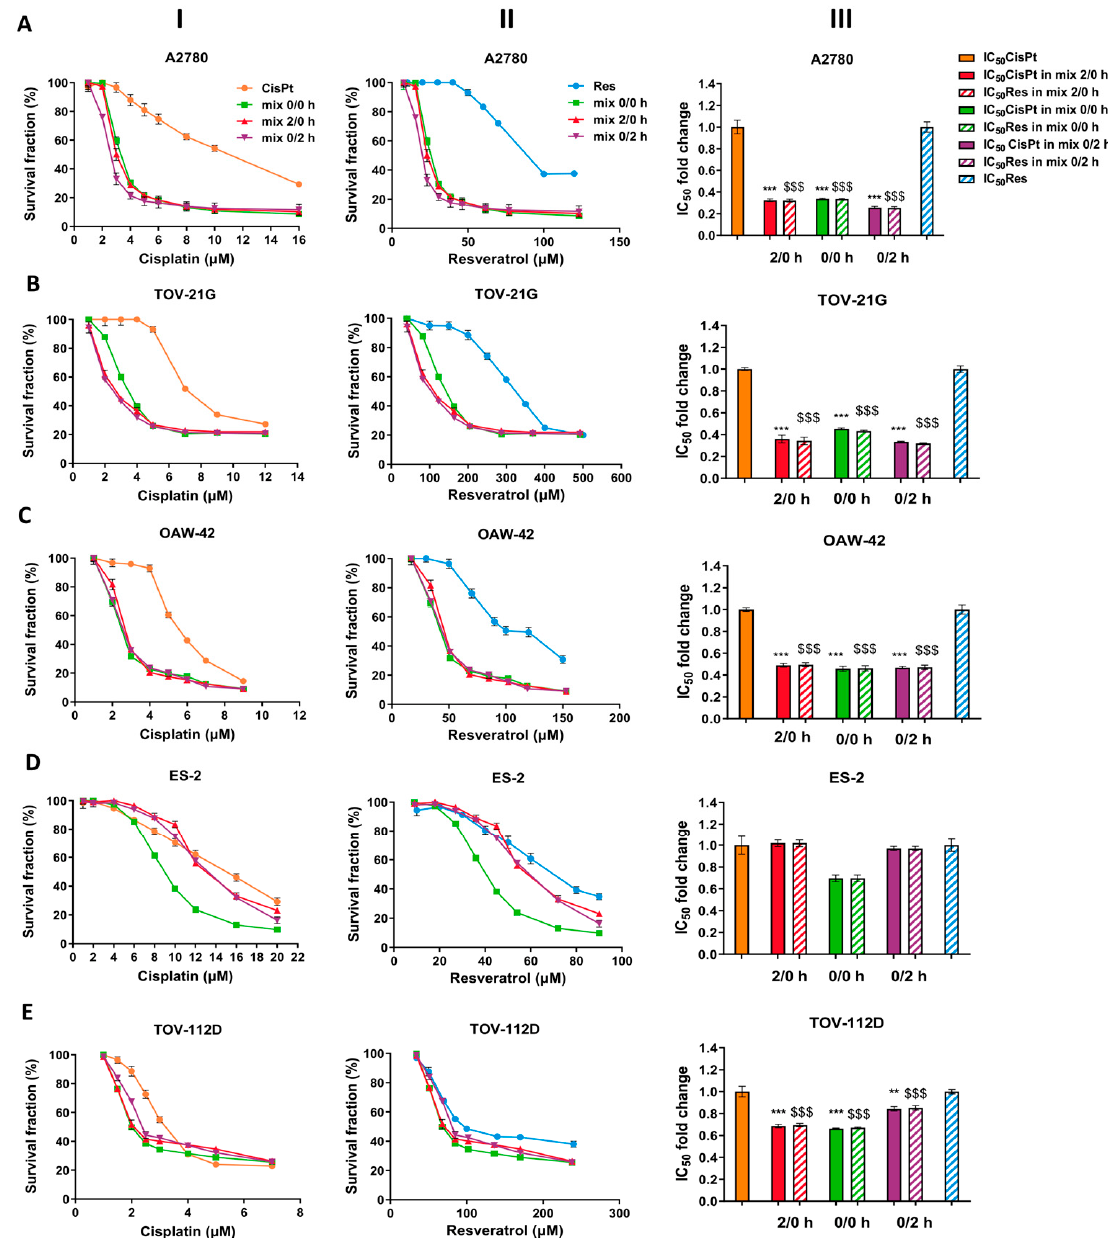
Figure 1. Effects of cisplatin, resveratrol, and combinations of the two drugs on OC cell line viability, estimated by alamarBlue assay. The human ovarian cancer cells were treated with cisplatin (CisPt) alone, resveratrol (Res) alone, and their combination (CisPt+Res) at a constant ratio (IC 50 ′ s ratio CisPt:Res) for 72 h. For combination studies, three different cell treatment protocols were used: both compounds were added at the same time (mix 0/0 h), Res given 2 h before CisPt (mix 2/0 h), or given 2 h after CisPt (mix 0/2 h). Survival curves of ( A ) A2780; ( B ) TOV-21G; ( C ) OAW-42; ( D ) ES-2; ( E ) TOV-112 cell lines; ( I ) CisPt alone vs. CisPt+Res; and ( II ) Res alone vs. CisPt+Res; ( III ) Changes of IC 50 doses of CisPt and Res in mixes 2/0 h, 0/0 h, and 0/2 h, respectively. The results of three experiments are presented as mean ± SD. Statistically significant (Student’s t -test and Mann–Whitney U test) changes of IC 50 in mixes compared to CisPt alone treatment, *** p < 0.001, ** p < 0.01; and $$$ p < 0.001, compared to Res alone treatment.